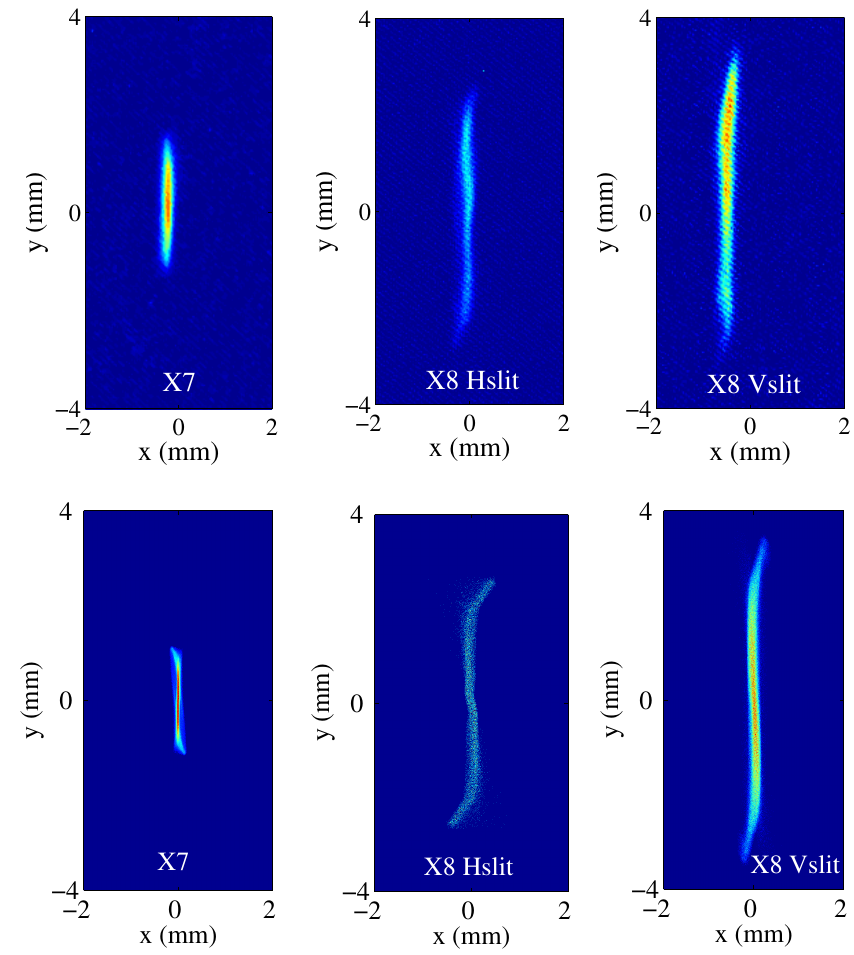
FIG. 4. (Color) The top three images are taken with digital cameras: beam at X7, horizontal and vertical slit images at X8. The bottom three are the corresponding beam profiles from ASTRA simulations. These images are associated with the flat-beam data presented in Table III.